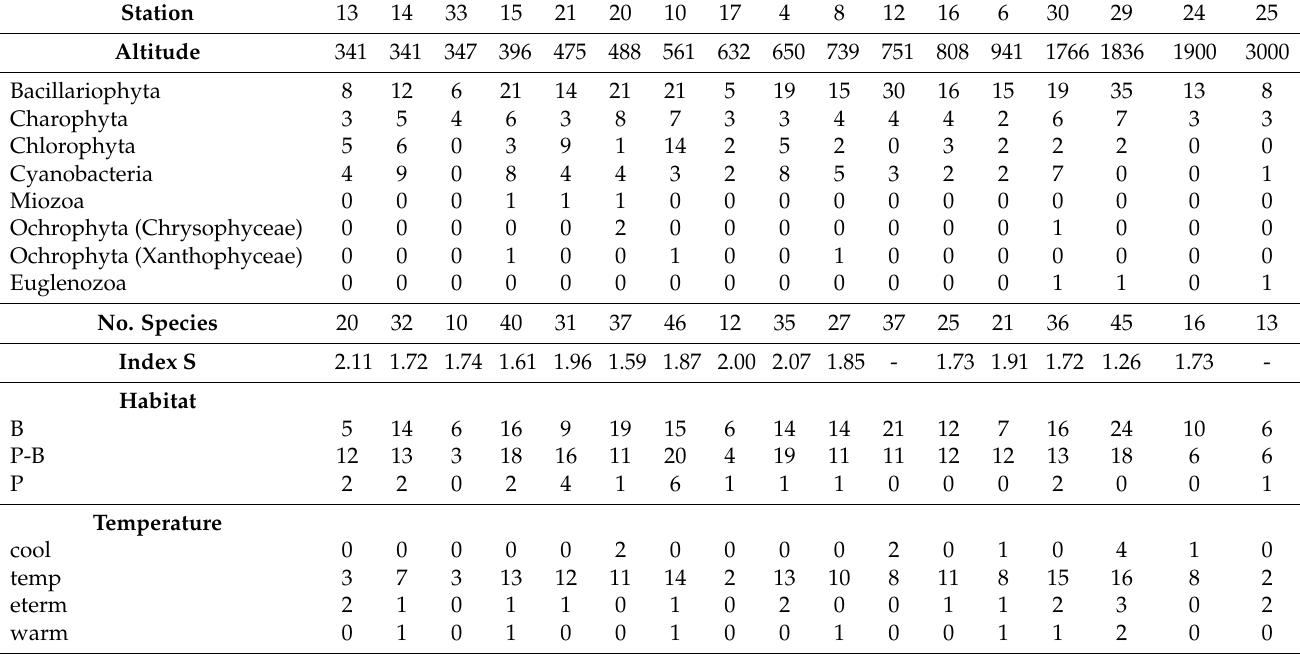
Table 4. Species richness in taxonomic phyla, number of indicator species, altitude, and saprobity index S at sampling stations in South and Southeast Kazakhstan 1